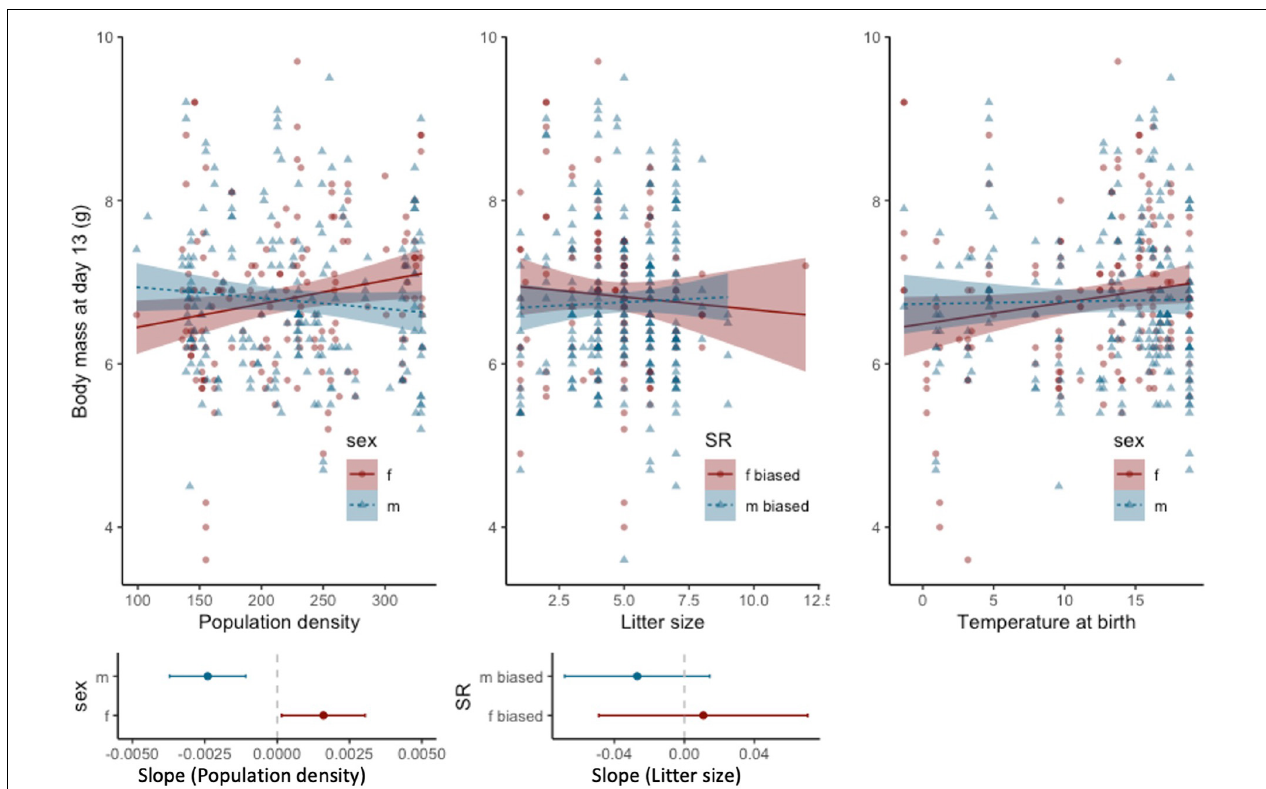
FIGURE 4 | Relationship of population density (number of individuals, left), litter size at day 13 (middle) and temperature at birth (right) with pup body mass at day 13; the shaded area indicates the 95% confidence intervals. Sex ratio (SR) was categorized and was considered male-biased when greater than 0.5 and female-biased when below 0.5. Figures below show slope analysis with 95% confidence